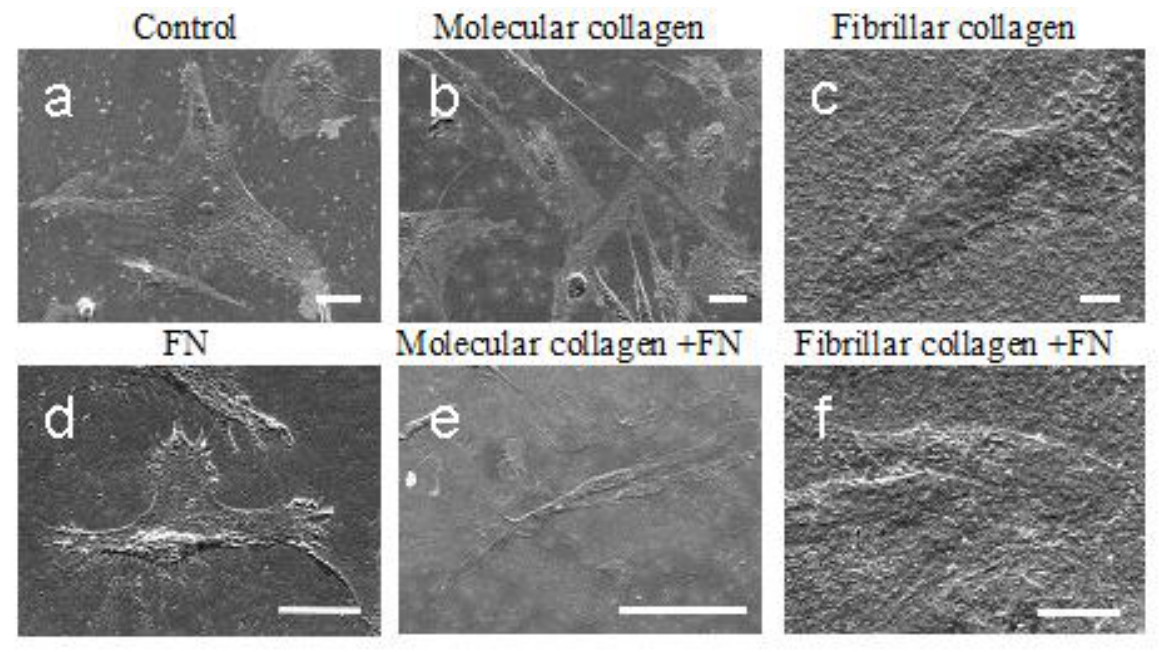
Figure 4. SEM images of MSCWJ-1 cell line after 1 day cultivation on molecular and fibrillar collagen with/without fibronectin (FN): ( a )—control (cover glass), ( b )—molecular collagen; ( c )—fibrillar collagen; ( d )—fibronectin; ( e )—molecular collagen + fibronectin; ( f )—fibrillar collagen + fibronectin.